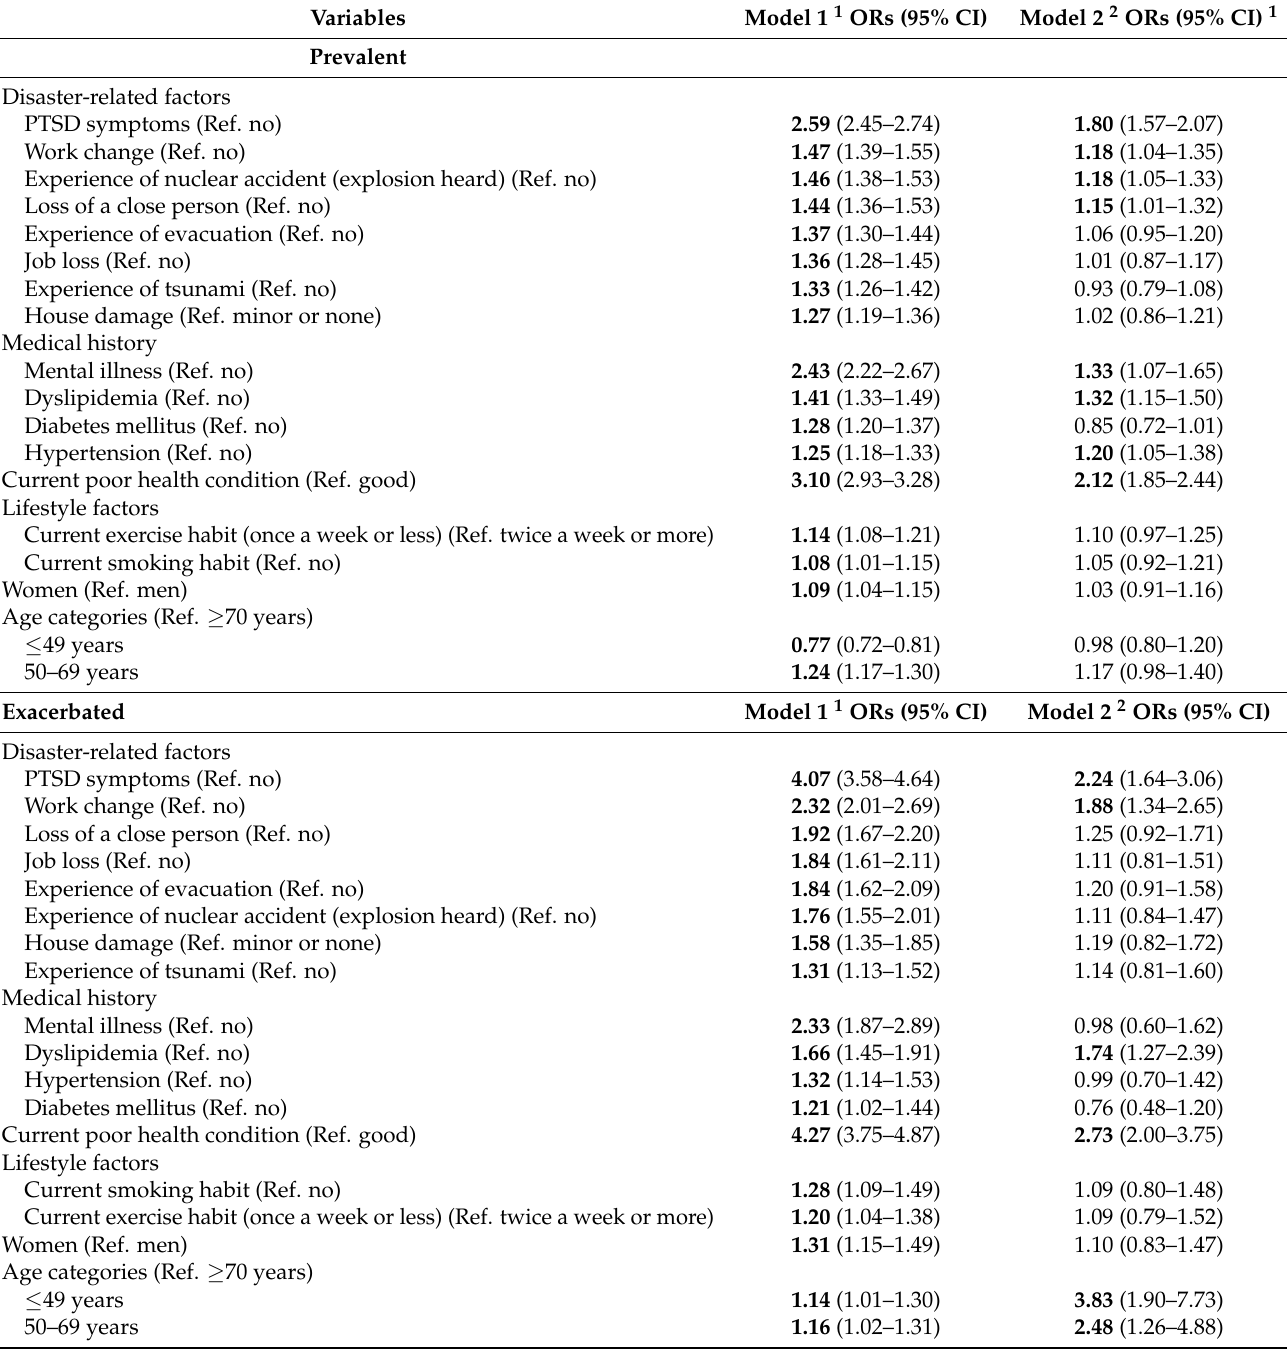
Table 2. Adjusted odds ratios and 95% CI for prevalent and for exacerbated oral